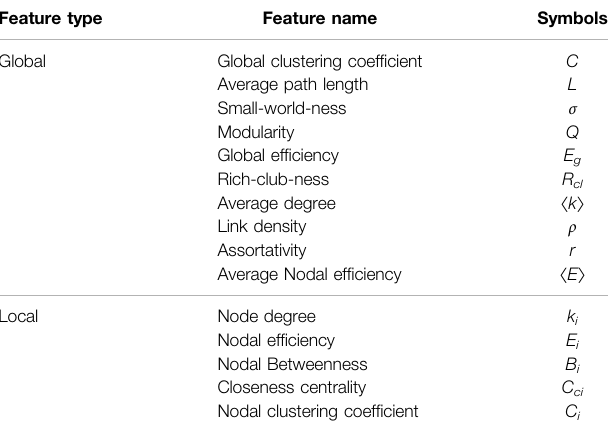
TABLE 1 | Features of functional